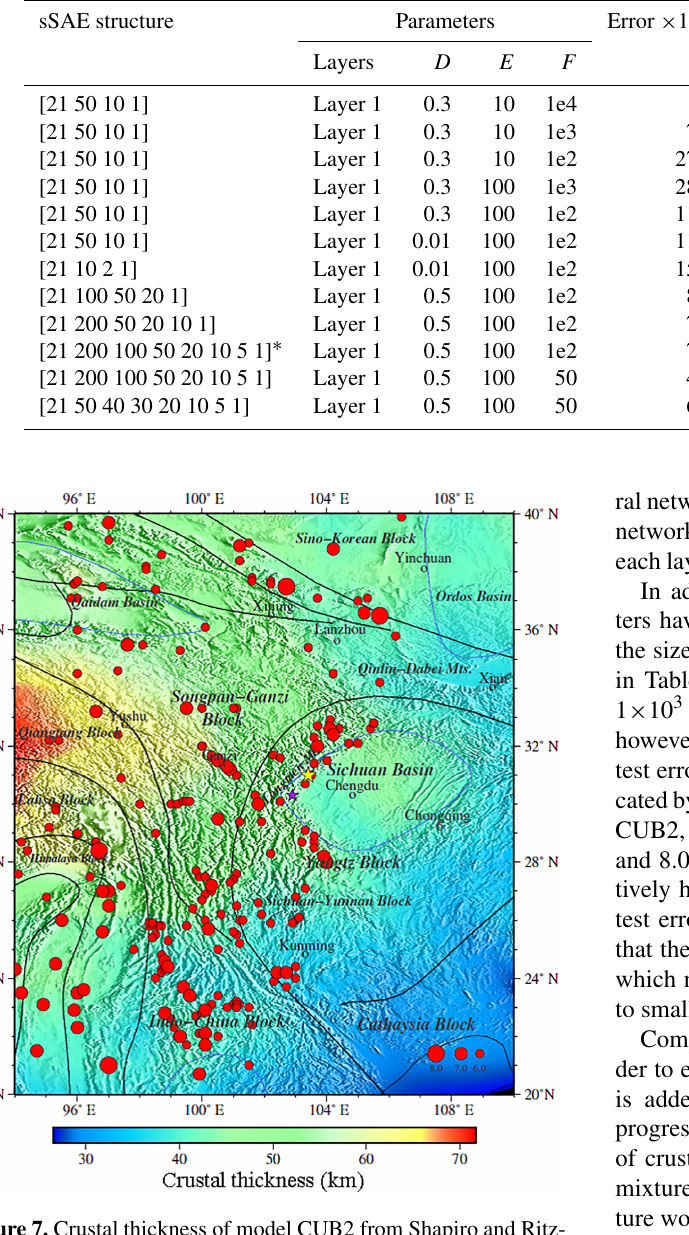
Figure 7. Crustal thickness of model CUB2 from Shapiro and Ritz- woller (2002). Note: the colour scale is not exactly the same as Fig.